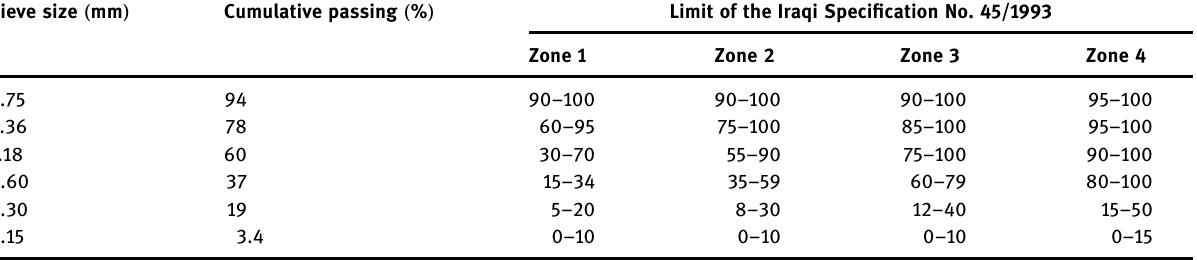
Table 3: Grading of the fi ne aggregate